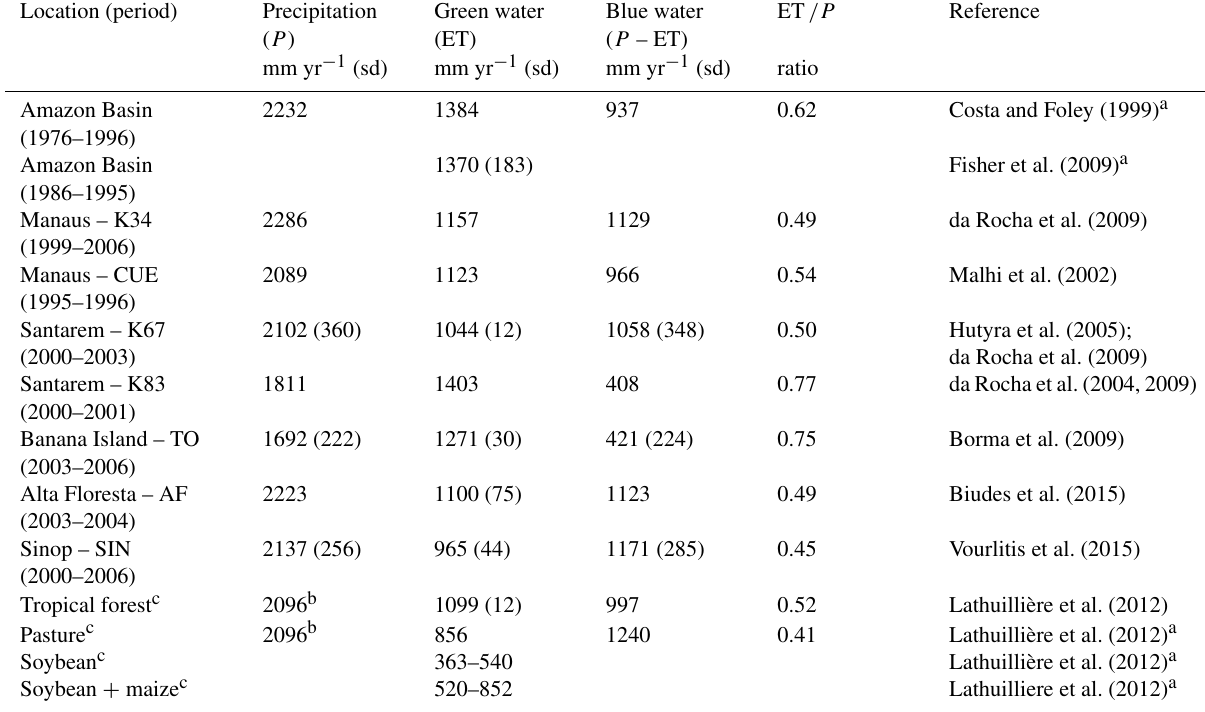
Table 2. Summary of precipitation ( P ) partitioning into green-water (evapotranspiration, ET) and blue-water resources ( P minus ET) from observations in Amazonia. All values are expressed in mmyr − 1 , with standard deviations of multi-year observations shown in brackets. Site locations are shown in Fig.